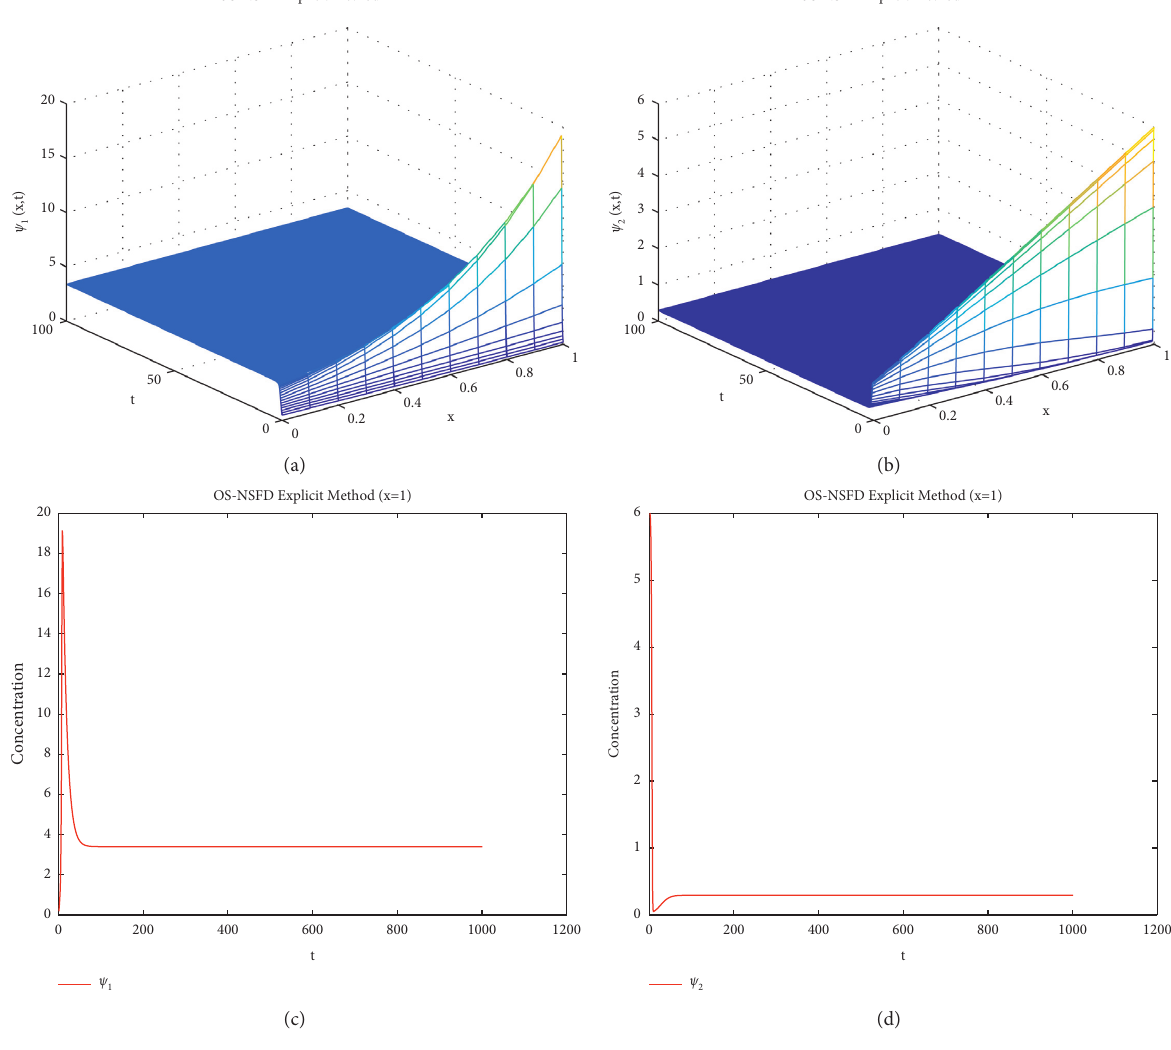
6: Mesh and plot graphs of ψ